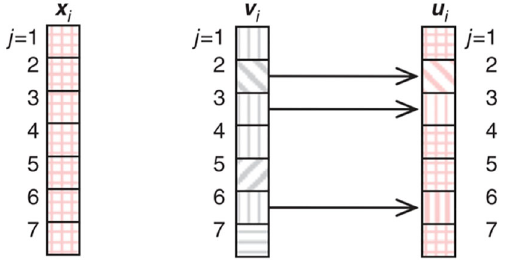
Fig. 3 Recombination process of DE